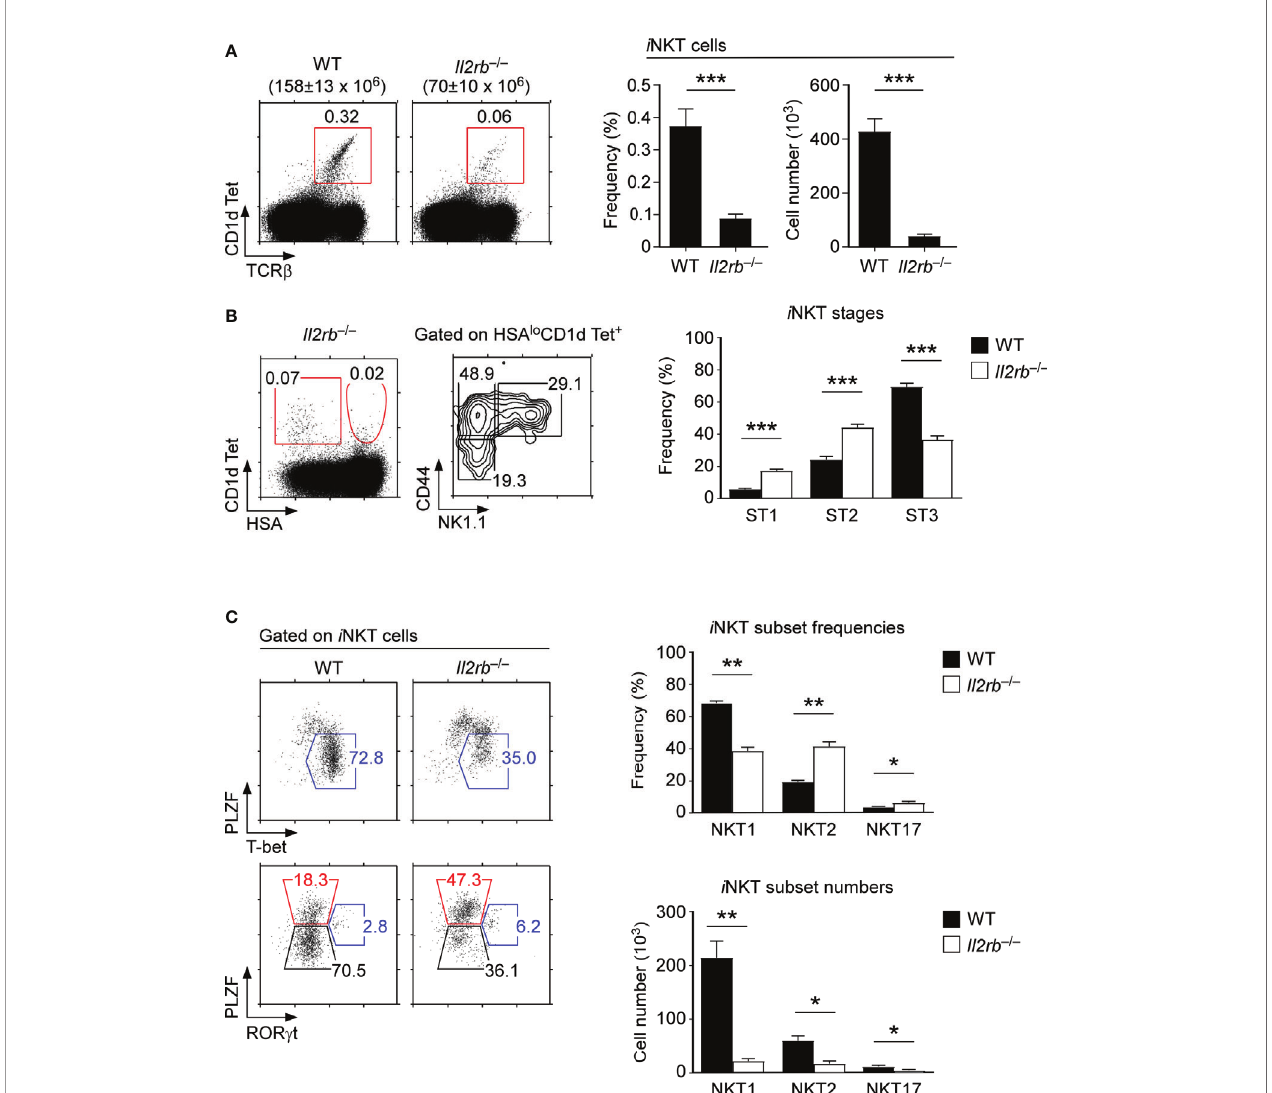
FIGURE 3 | An IL-2R b requirement for thymic i NKT cell differentiation (A) Frequency and number of thymic i NKT cells in Il2rb – / – and WT littermate mice. Dot plots show thymic i NKT cells as identi fi ed by CD1dTet and TCR b staining. Total thymocyte numbers are shown above the dot plots as the means ± SEM (left). Bar graphs show the frequencies and numbers of i NKT cells from the indicated mice (right). The dot plot is representative, and the bar graphs are a summary of 4 independent experiments with a total of 13 Il2rb – / – and 7 WT littermate mice. (B) Thymic i NKT cell differentiation in Il2rb – / – mice. HSA lo mature i NKT cells were stained for CD44 and NK1.1 to identify ST1, ST2, and ST3 cells in the indicated mice (left). The bar graph shows the frequencies of ST1, ST2, and ST3 cells in Il2rb – / – and WT littermate mice (right). The dot and contour plots are representative, and the bar graph shows the summary of 4 independent experiments. (C) Dot plots show the thymic i NKT subset composition in Il2rb – / – and WT littermate mice (left). The bar graph on top shows the frequency of thymic i NKT subsets as summary of 5 independent experiments with a total of 14 Il2rb – / – and 8 WT littermate mice. The bottom bar graph shows the cell numbers of thymic i NKT subsets as the summary of 4 independent experiments with a total of 9 Il2rb – / – and 4 WT littermate control mice. *P < 0.05; **P < 0.01; ***P <